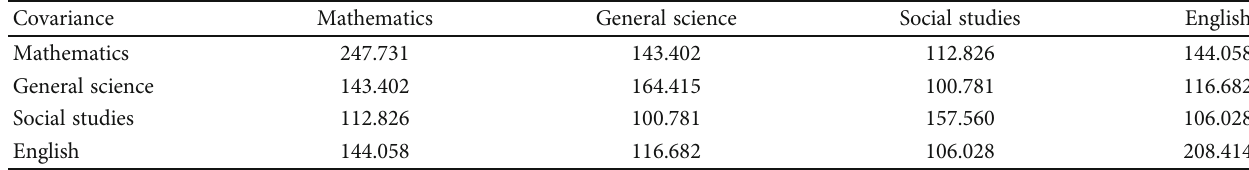
Table 11: The covariance for total tribal boy students.